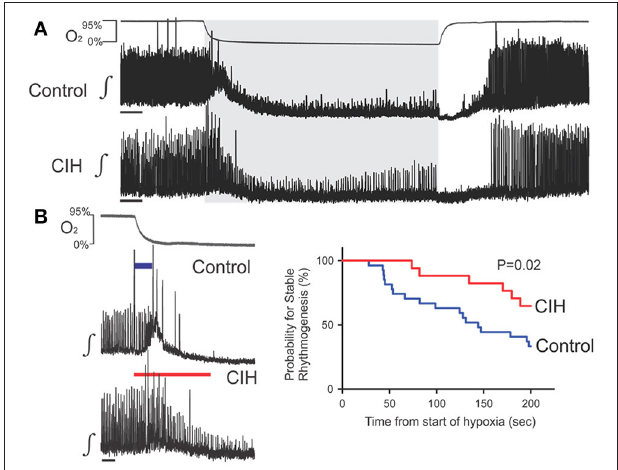
FIGURE 3 | CIH affects the augmentation of rhythmogenesis during the initial period of hypoxia. (A) Representative examples of rhythmogenesis during the perihypoxic interval showing that hypoxia and reoxygenation produces similar stereotypical responses in the isolated preBötC from control and CIH exposed mice. (B) Left: Integrated traces of the preBötC rhythm ( R ) during the initial period of hypoxia illustrating the early failure of rhythms from the control (top, blue bar: 44s) vs. the CIH group (bottom, red bar 200s). Scale Bars: 20s. Right: Kaplan-Meier curves for the control (blue) and CIH (red) groups during the initial 200s of hypoxia illustrating the increased propensity of failure in the control group compared to the CIH group.